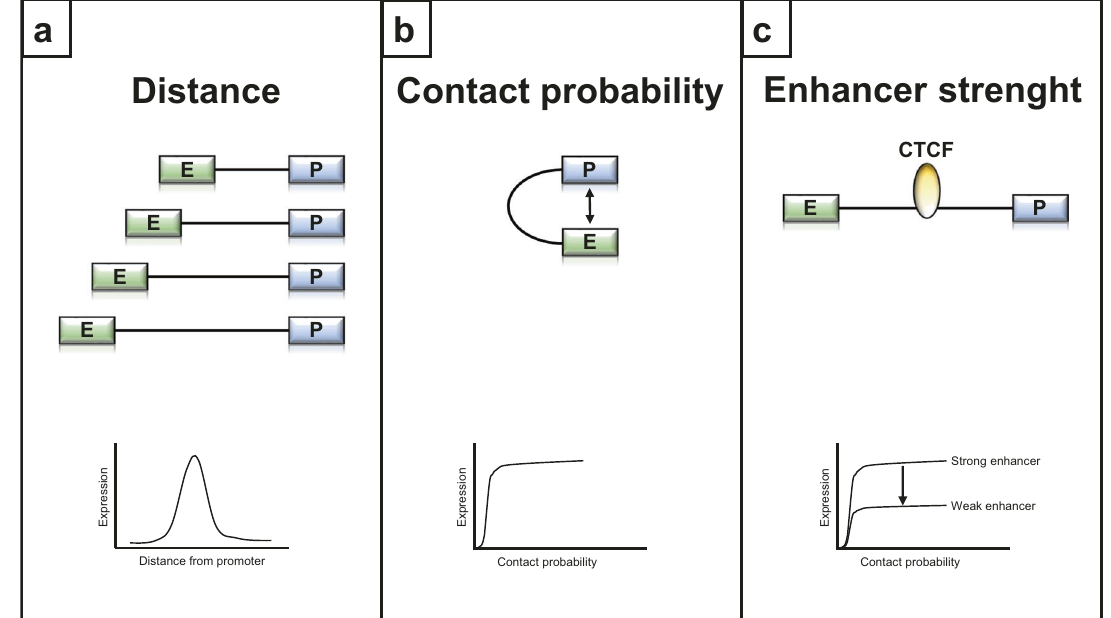
Fig. 1 Schematic summary of the main fi ndings of Zuin et al. a Gene expression depends on the enhancer-promoter distance. b Gene expression depends on contact probability by following a nonlinear relationship. c Enhancer strength determines its sensitivity to CTCF- mediated